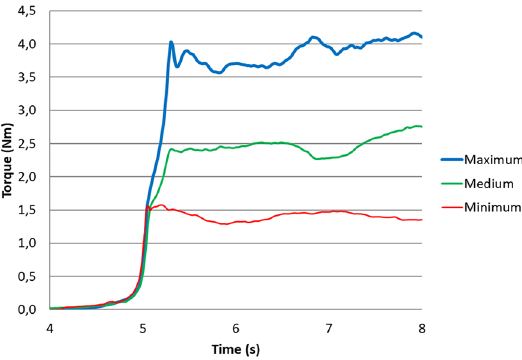
Figure 11. Torque measured over the pin during the BUT test.